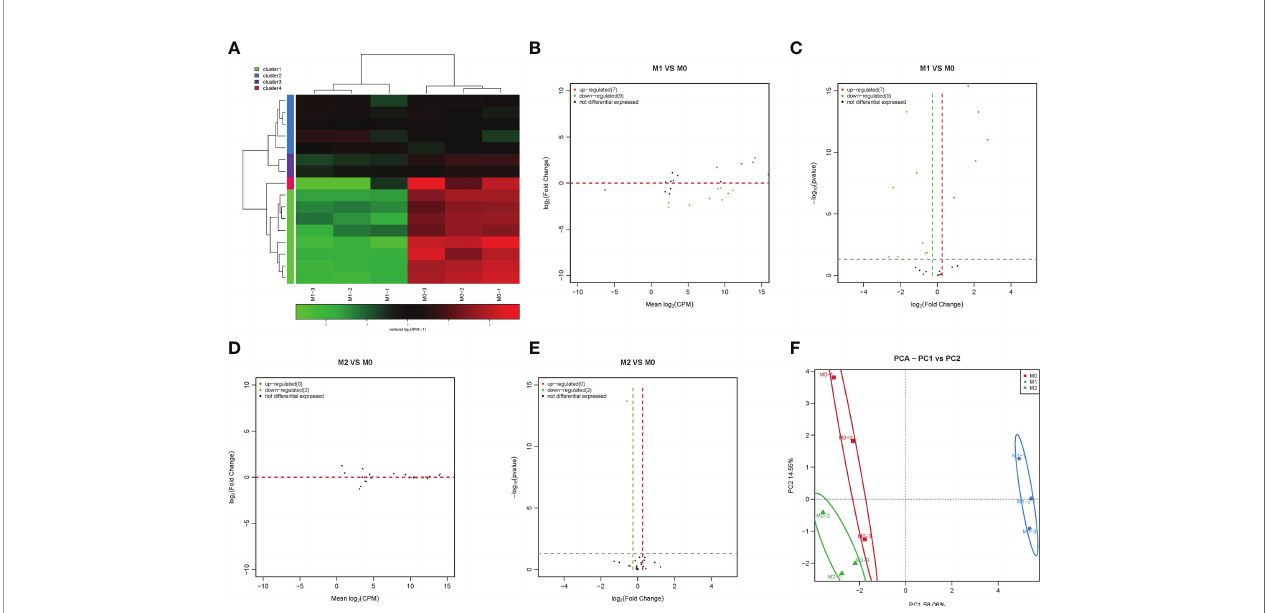
FIGURE 5 | Changes in repeat RNA expression during macrophage polarization. Hotmap (A) , MA (B) and volcano plot (C) show the small RNA sequencing results for the expression of repeat RNA in M0 and M1 macrophages. MA (D) and volcano (E) show the small RNA sequencing results for the expression of repeat RNA in M0 and M2 macrophages. (F) PCA of repeat RNA expression in the M0, M1 and M2